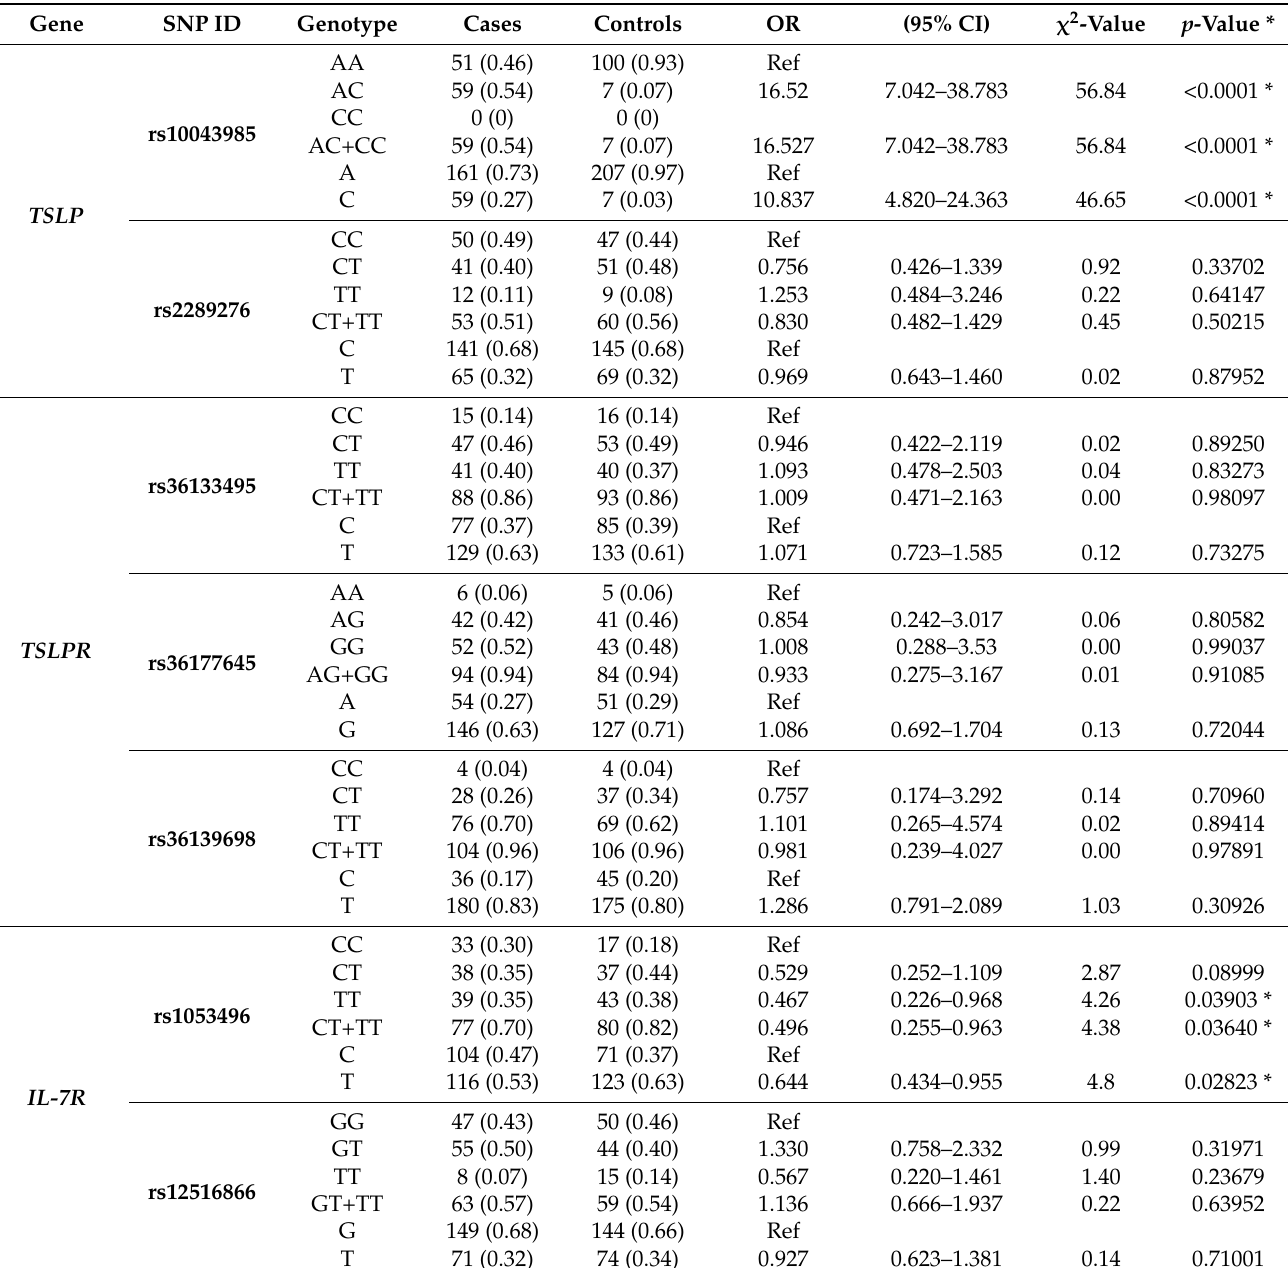
Table 4. Genotype frequencies of TSLP, TSLPR, and IL-7R gene polymorphisms in CRC and